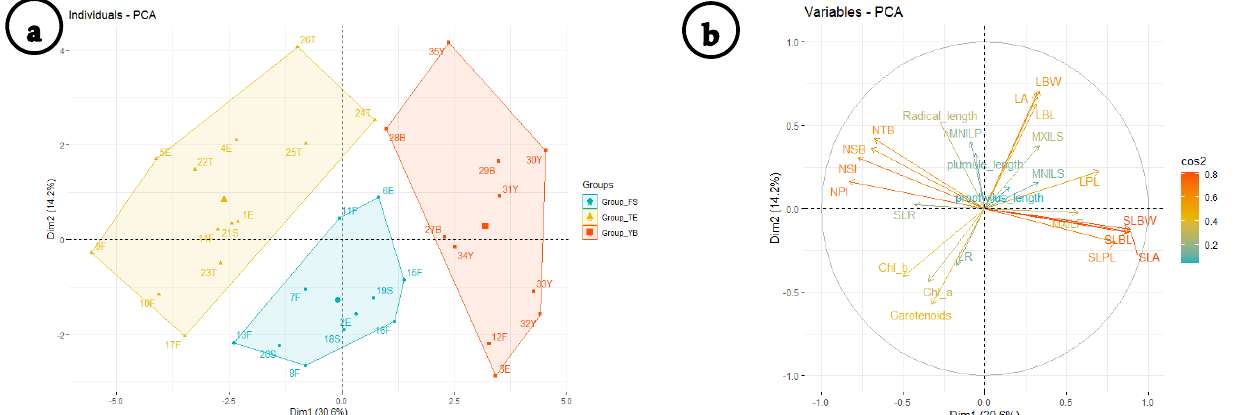
Figure 3. ( a ) Principal component analysis (PCA) of 35 Trianthema portulacastrum samples with 30.6% total variation explained along the first axis (Dim1) followed by a total 14.2% of variation explained along the second axis (Dim2). ( b ) Correlation between different variables and the first two components. Color intensity and length of the variable arrow in graph ( b ) is representing the importance of different variables where longer arrows with high color intensities are representing variables that contribute the most to the discrimination of the three groups.